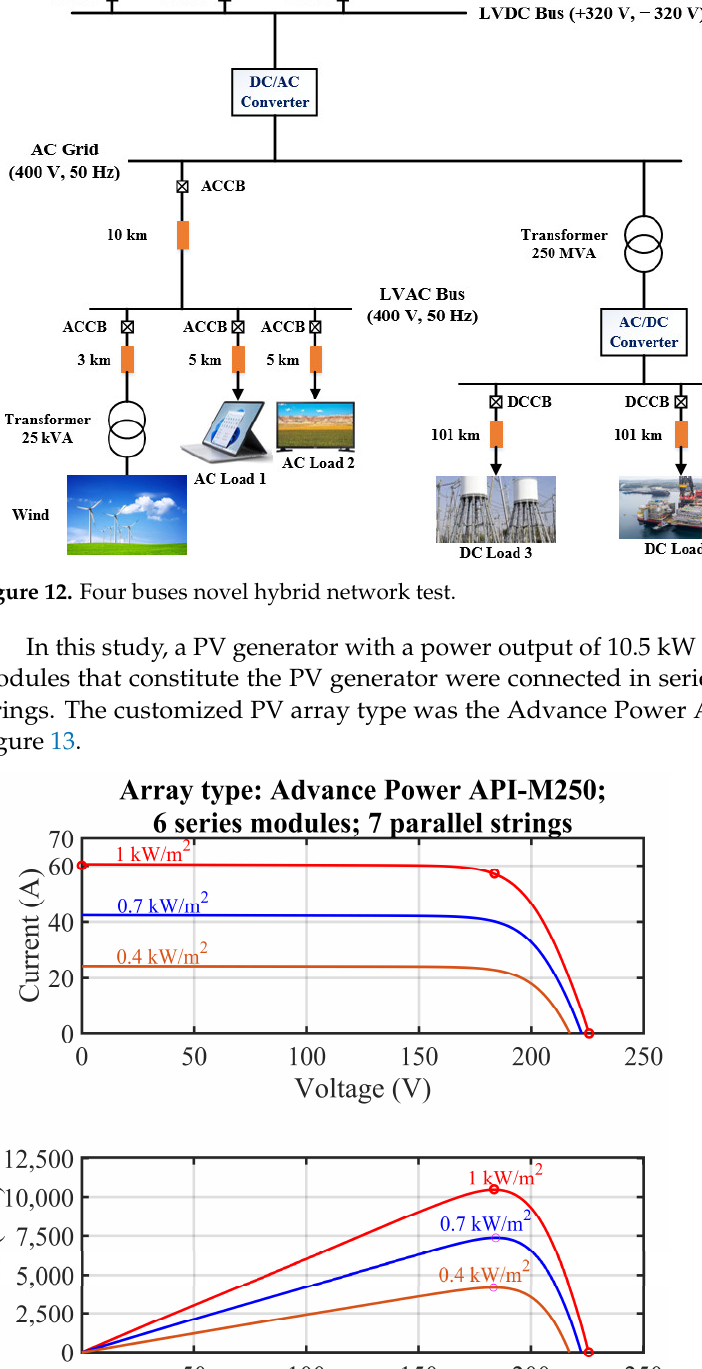
Table 1. Proposed test system parameters.